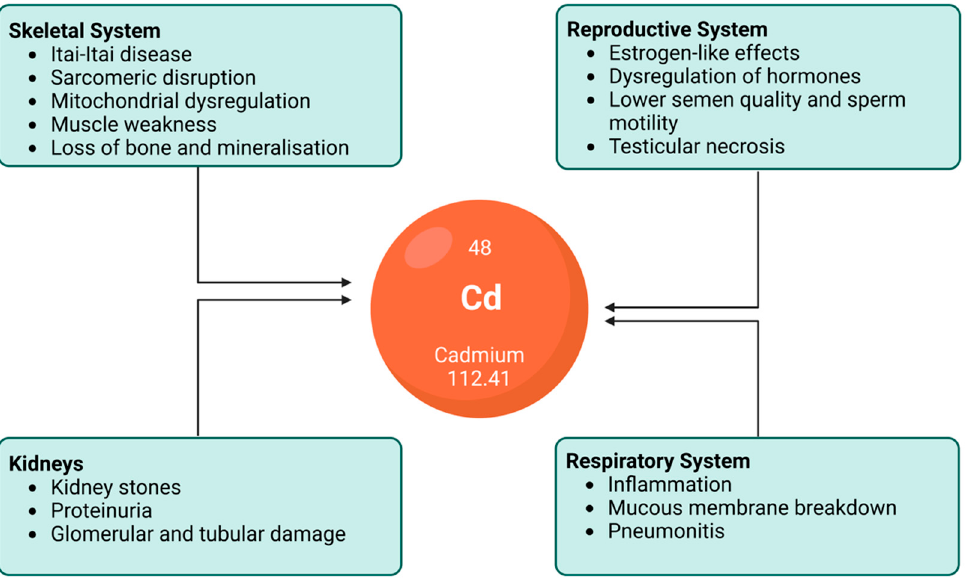
Figure 4. An illustration depicting the effects of chronic cadmium exposure on various human organs and systems. While not an exclusive list, this figure demonstrates the importance of mitigating excess cadmium ingestion.